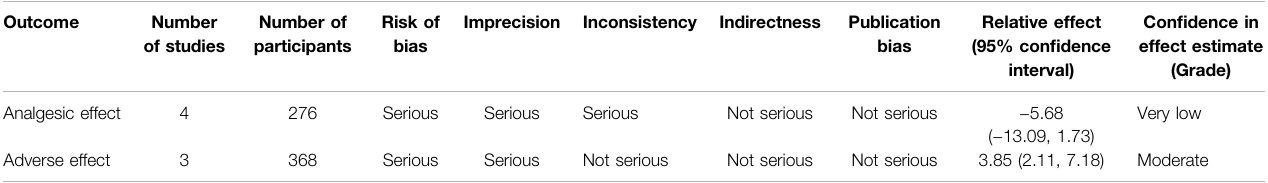
TABLE 4 | GRADE (Grading of Recommendations, Assessment, Development and Evaluations) criteria for assessing the quality of